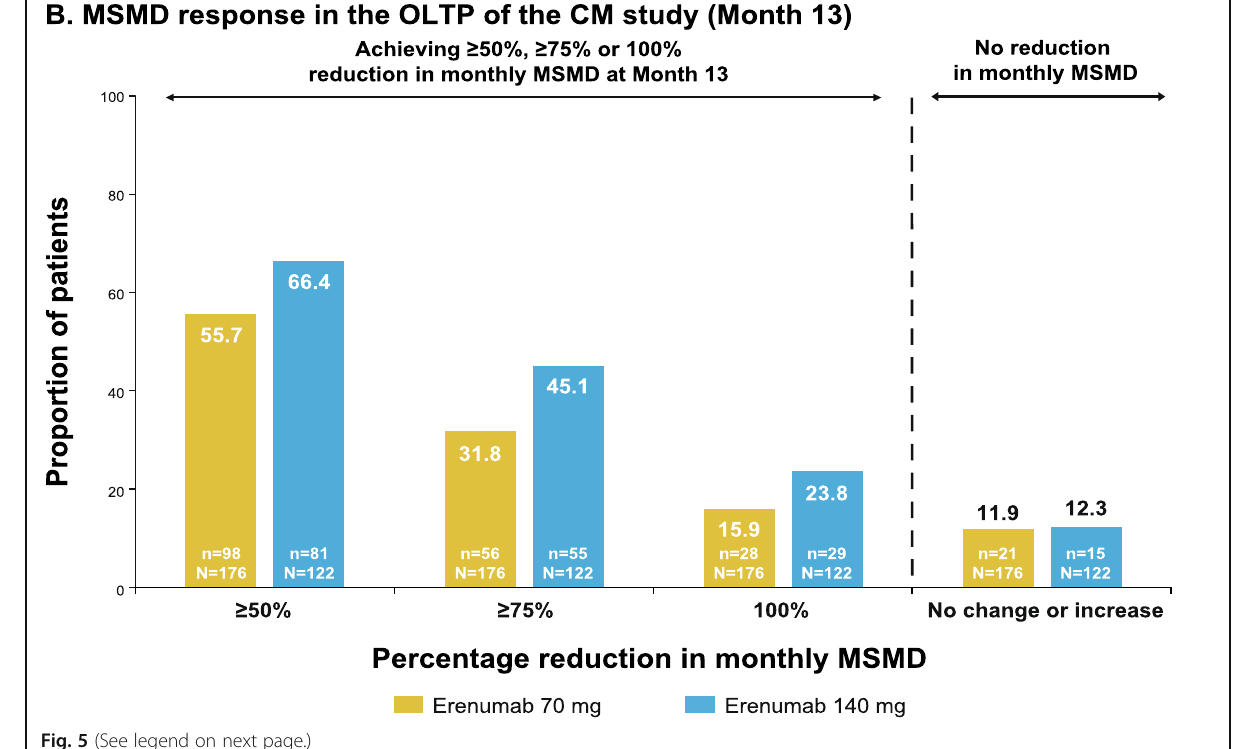
Fig. 5 (See legend on next